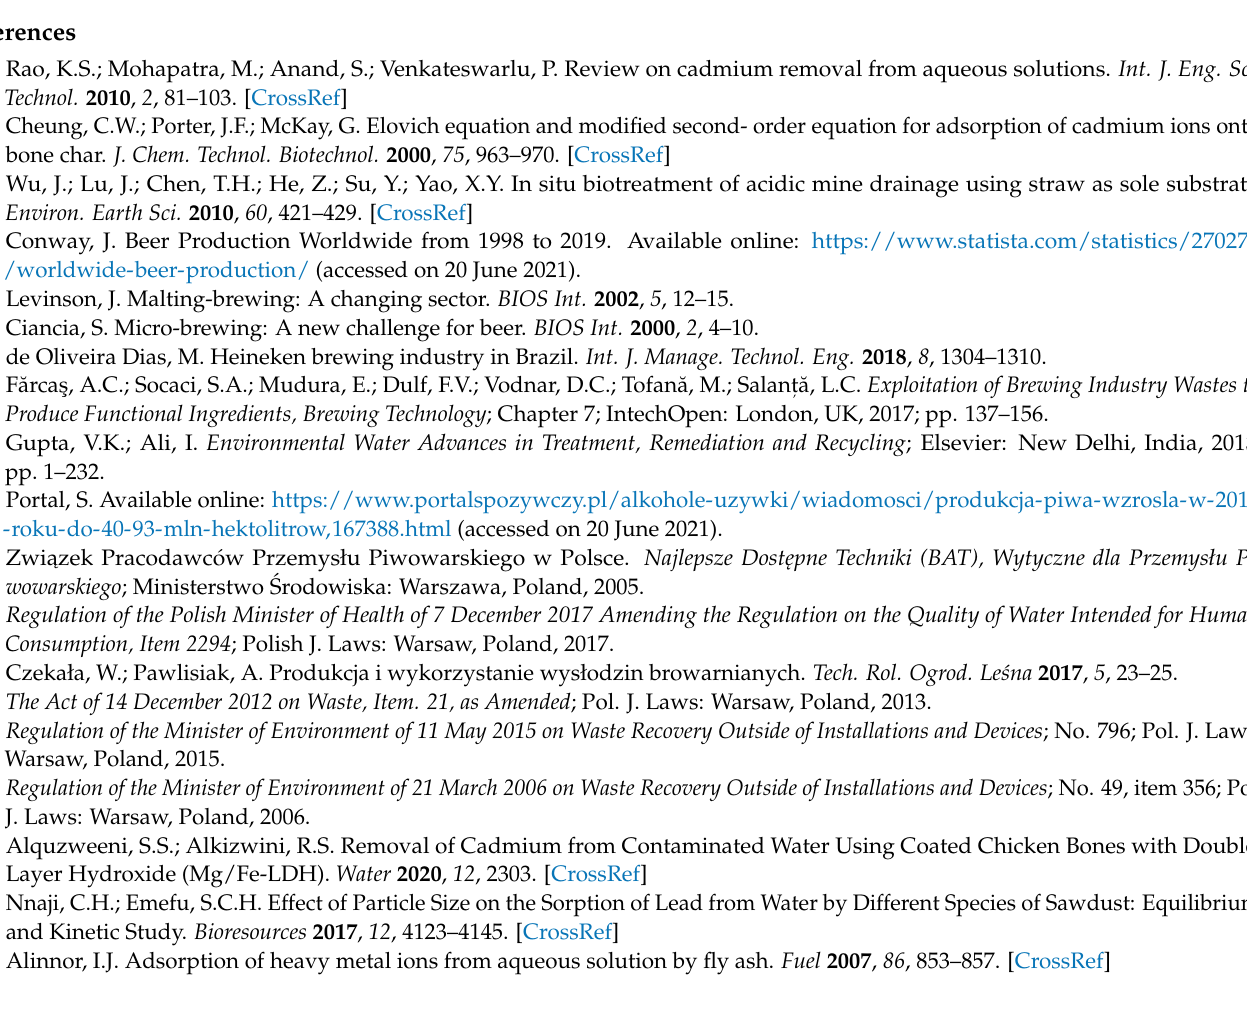
kinetic isotherm for the biosorption of Cd(II) with brewer’s grains (BG dosage 10 g/L), Figure S7: Langmuir kinetic isotherm for the biosorption of Cd(II) with brewer’s grains (BG dosage 30 g/L), Figure S8: Langmuir kinetic isotherm for the biosorption of Cd(II) with brewer’s grains (BG dosage 50 g/L), Figure S9: Freundlich kinetic isotherm for the biosorption of Cd(II) with brewer’s grains (BG dosage 1 g/L), Figure S10: Freundlich kinetic isotherm for the biosorption of Cd(II) with brewer’s grains (BG dosage 5 g/L), Figure S11: Freundlich kinetic isotherm for the biosorption of Cd(II) with brewer’s grains (BG dosage 10 g/L), Figure S12: Freundlich kinetic isotherm for the biosorption of Cd(II) with brewer’s grains (BG dosage 30 g/L), Figure S13: Freundlich kinetic isotherm for the biosorption of Cd(II) with brewer’s grains (BG dosage 50